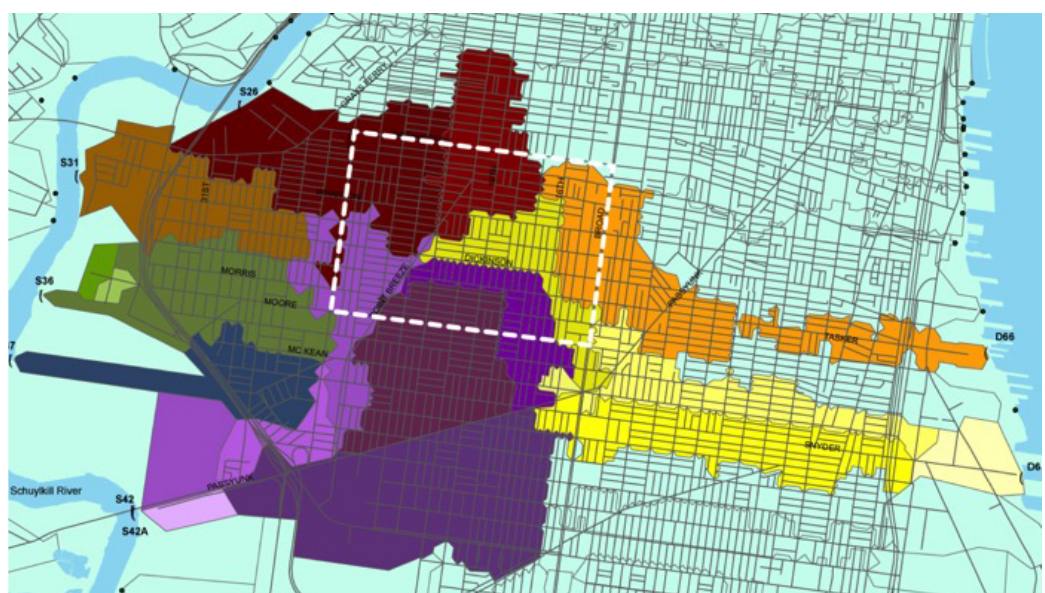
Figure 1. The Point Breeze neighborhood, with CSO drainage